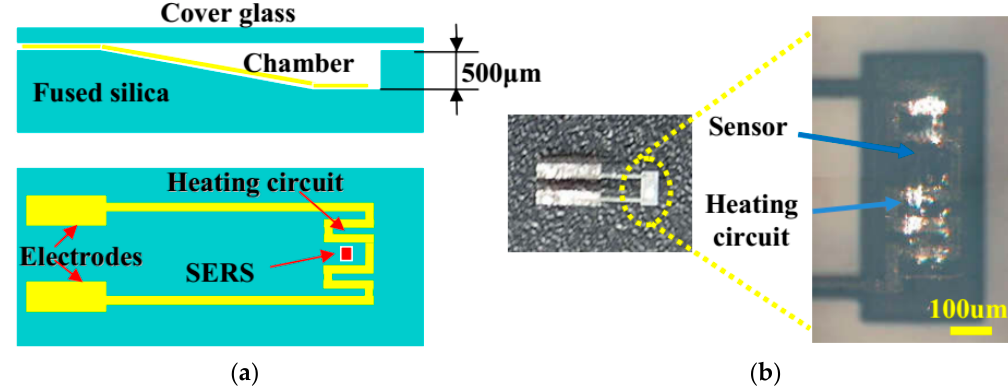
Figure 10. ( a ) Schematic illustration of side view (upper panel) and top view (lower panel) and ( b ) digital camera captured image of the integrated Raman bio-chip.